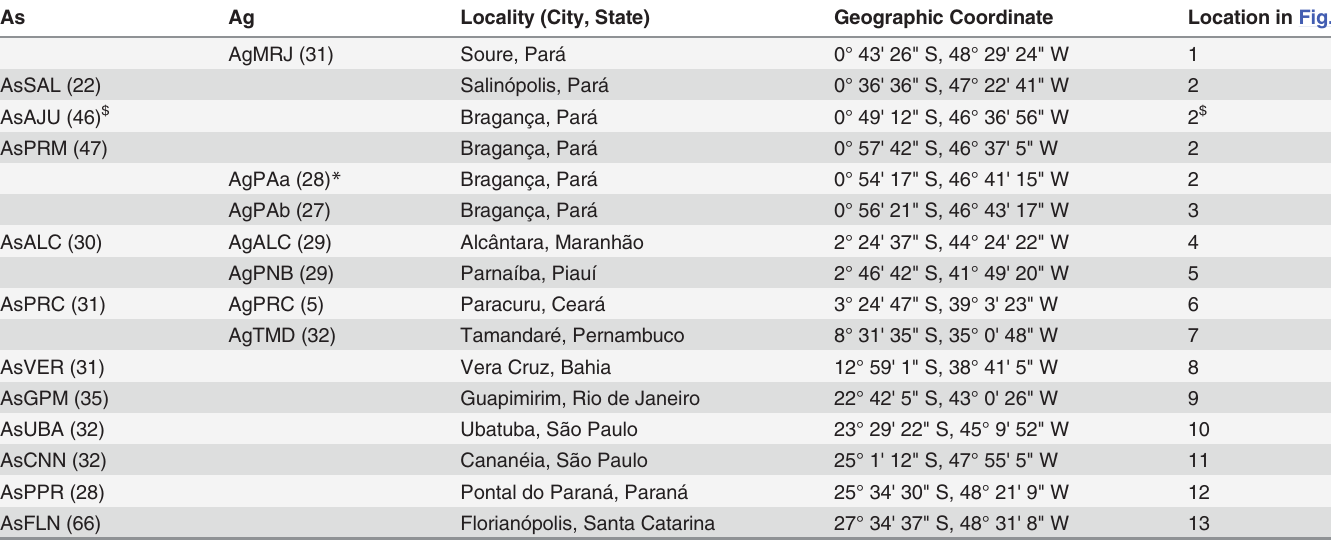
Sampled populations of A . germinans (Ag) and A . schaueriana (As) are indicated by three capital letters. Sample sizes are indicated with parentheses. The city and state in Brazil, geographic coordinate and numbers corresponding to Fig. 1 are denoted for each site. * indicates a sample under a reduced inundation frequency [19]; $ indicates the locality where the progeny array was